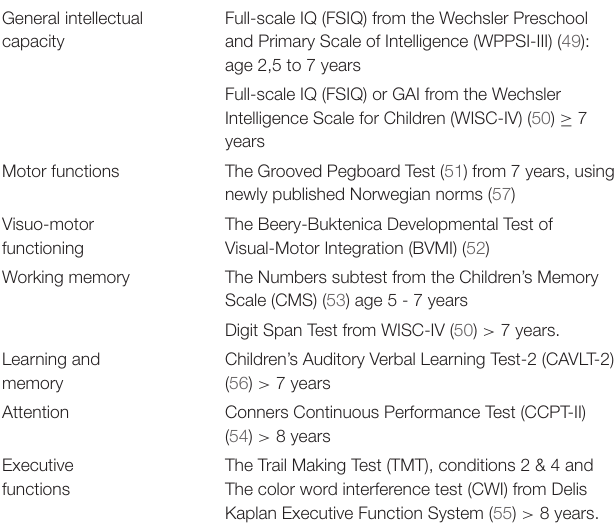
TABLE 1 | Neuropsychological test measures. General intellectual